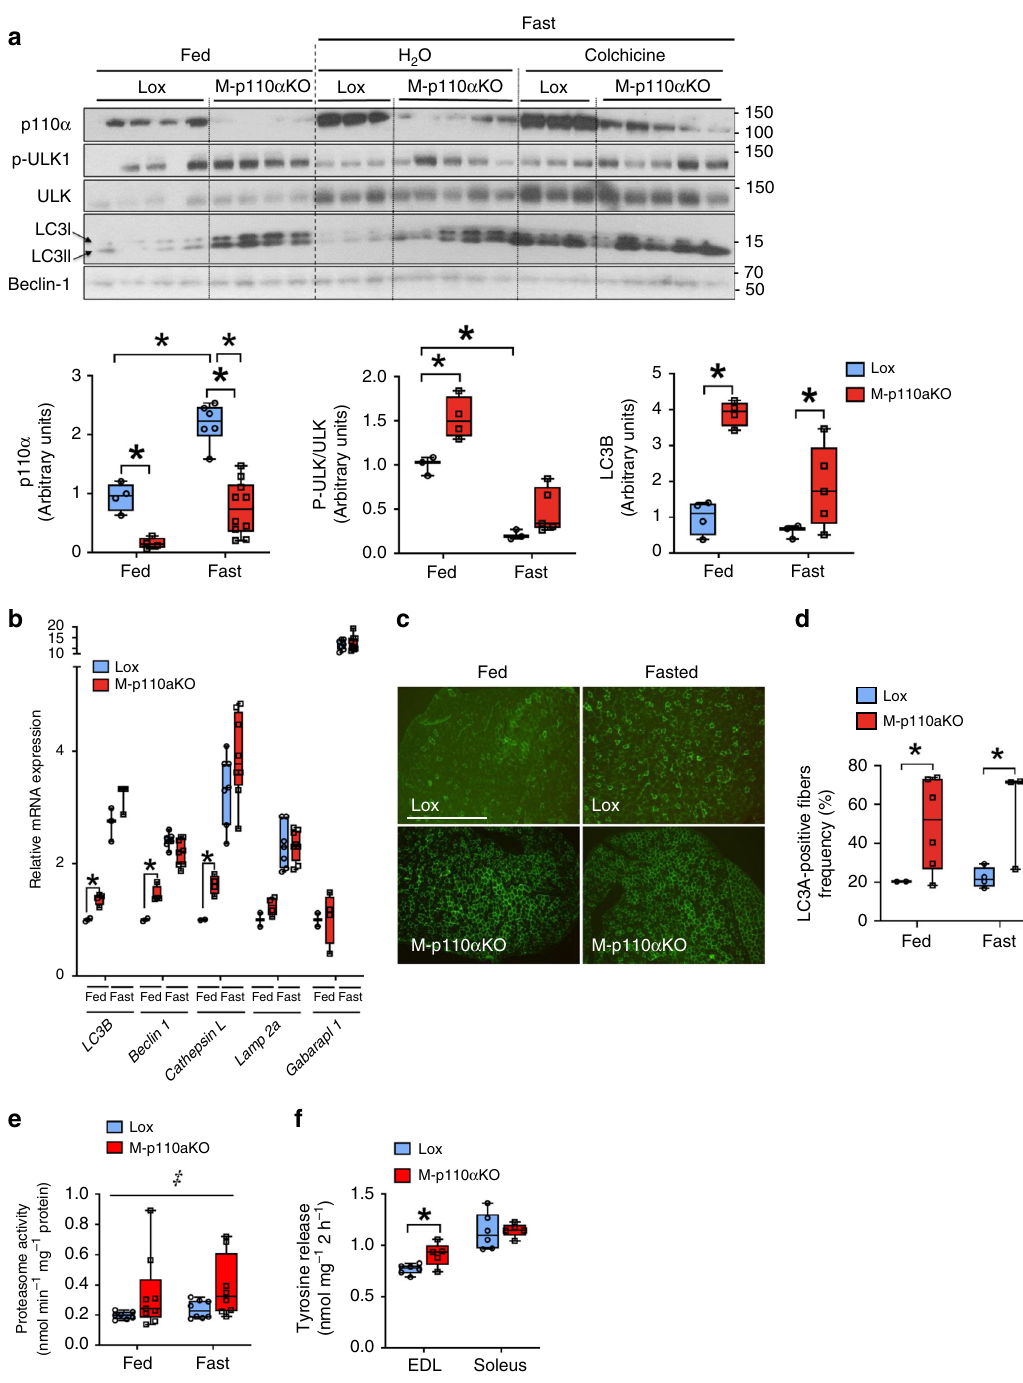
Fig. 2 Increased markers of autophagy – lysosomal degradation and proteasome activity. a Western blot and densitometric analysis of autophagy intermediates in quadriceps muscles of M-p110 α KO and controls in fed, fasted, and fasted plus treated with colchicine. b mRNA expression of autophagy genes in TA muscles of M-p110 α KO and controls ( n = 4). c LC3A immunostaining of quadriceps from M-p110 α KO and controls (scale bar = 500 μ m). d Percentage of LC3A-positive fi bers per cross-section of quadriceps muscles in ( c ) ( n = 4 – 7). e Proteasome activity in gastrocnemius muscles of M- p110 α KO and controls using a peptidyl glutamyl-like (LLE) substrate ( n = 8). f Proteolysis rate measured by tyrosine release ex vivo in EDL and soleus muscles isolated from fed control and M-p110 α KO at 24 months of age (ctrl, n = 5; KO, n = 6). Mice for Fig. 2a – e were 3-month old, and mice for Fig. 2f were 24-month old. Mice for Fig. 2a – e were fasted for 24h or randomly fed. * P < 0.05 by Student ’ s t test; ‡ P < 0.05 by two-way ANOVA. Box plots visualize the fi ve-number summary of the data set (minimum, lower quartile, median, upper quartile, and maximum). The data are mean± SEM in bar